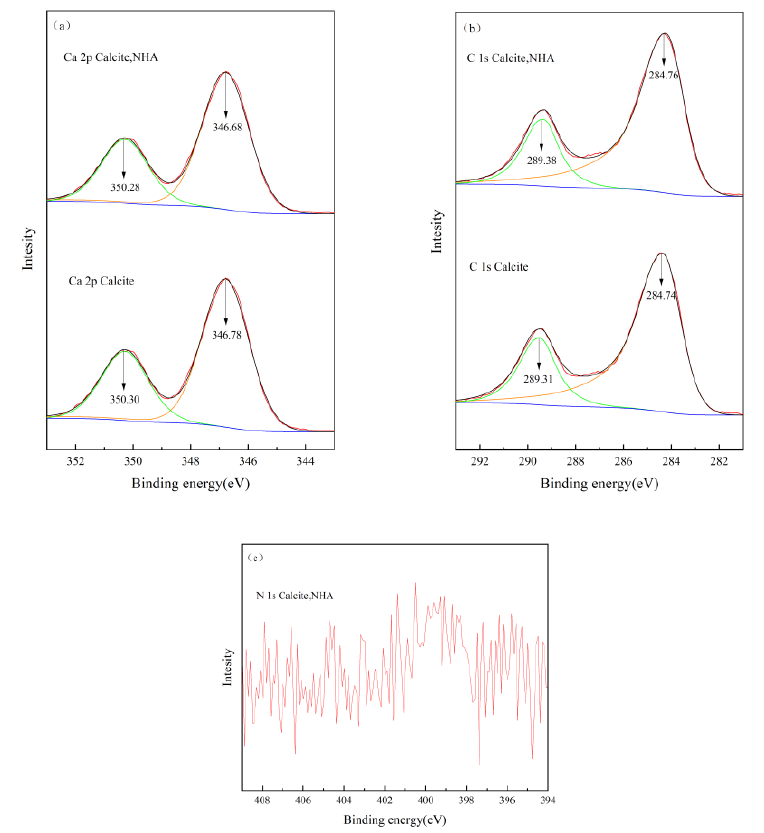
Figure 9. High-resolution XPS spectra of Ca 2p ( a ), C 1 s ( b ) and N 1 s ( c ) of pure, NHA-treated calcite particles, respectively.